Question: Which visualization type does this figure use?
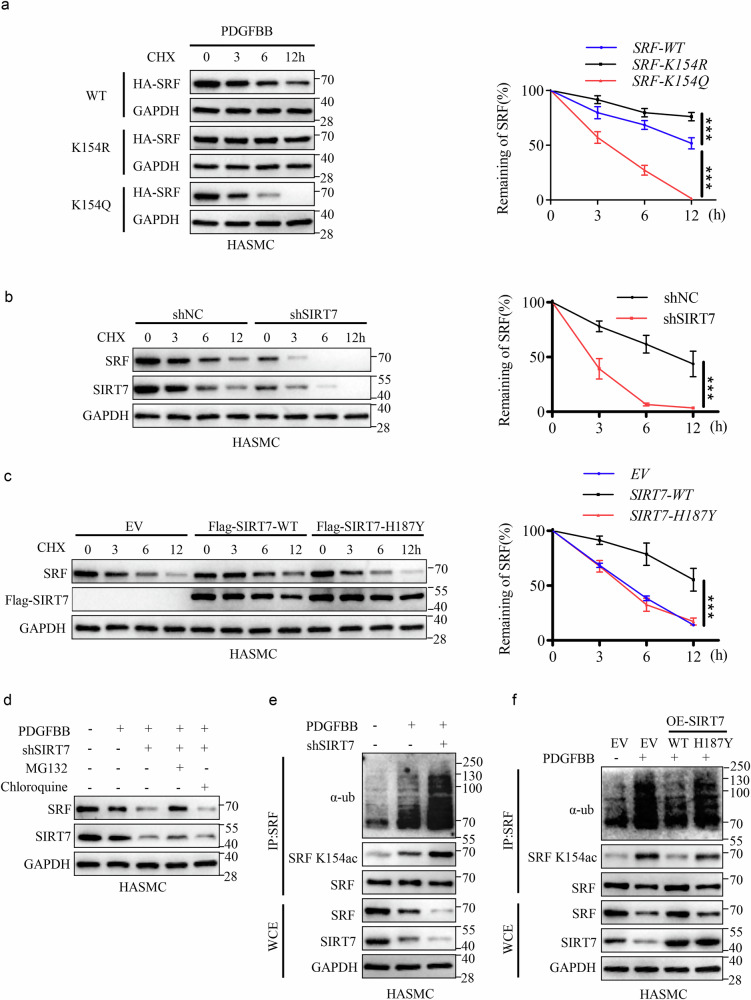
Answer: line